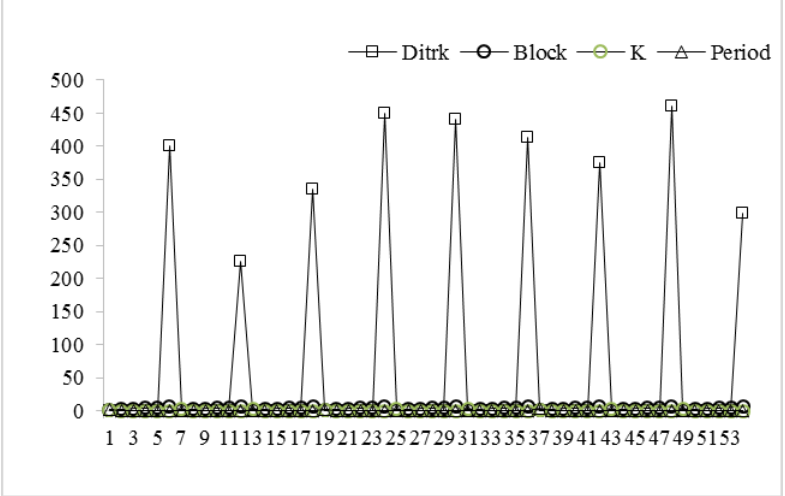
Figure 5: The evolution of variables of containers C1 in the case of 6 blocks